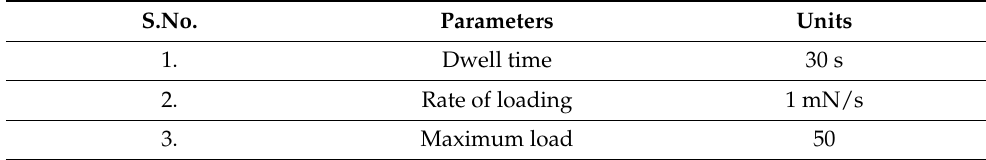
Table 3. Parameters used during the